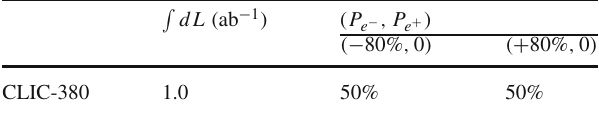
Fig. 6 The95%CLupperboundsof a NP τ asfunctionsofthesystematic error at the ILC-250, the FCC ee - H , and CEPC- H experiments with the designed integrated luminosities of 2.0, 5.0, and 5.6 ab − 1 , respectively Table 2 Luminosity sharing between different polarization configura- √ s = 380 GeV tions [64,65] for the CLIC at